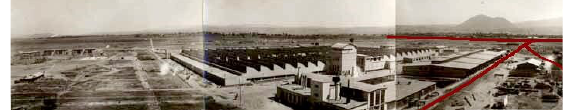
Figure 2. the general view of Kayseri Factory, on the left the weaving ateliers